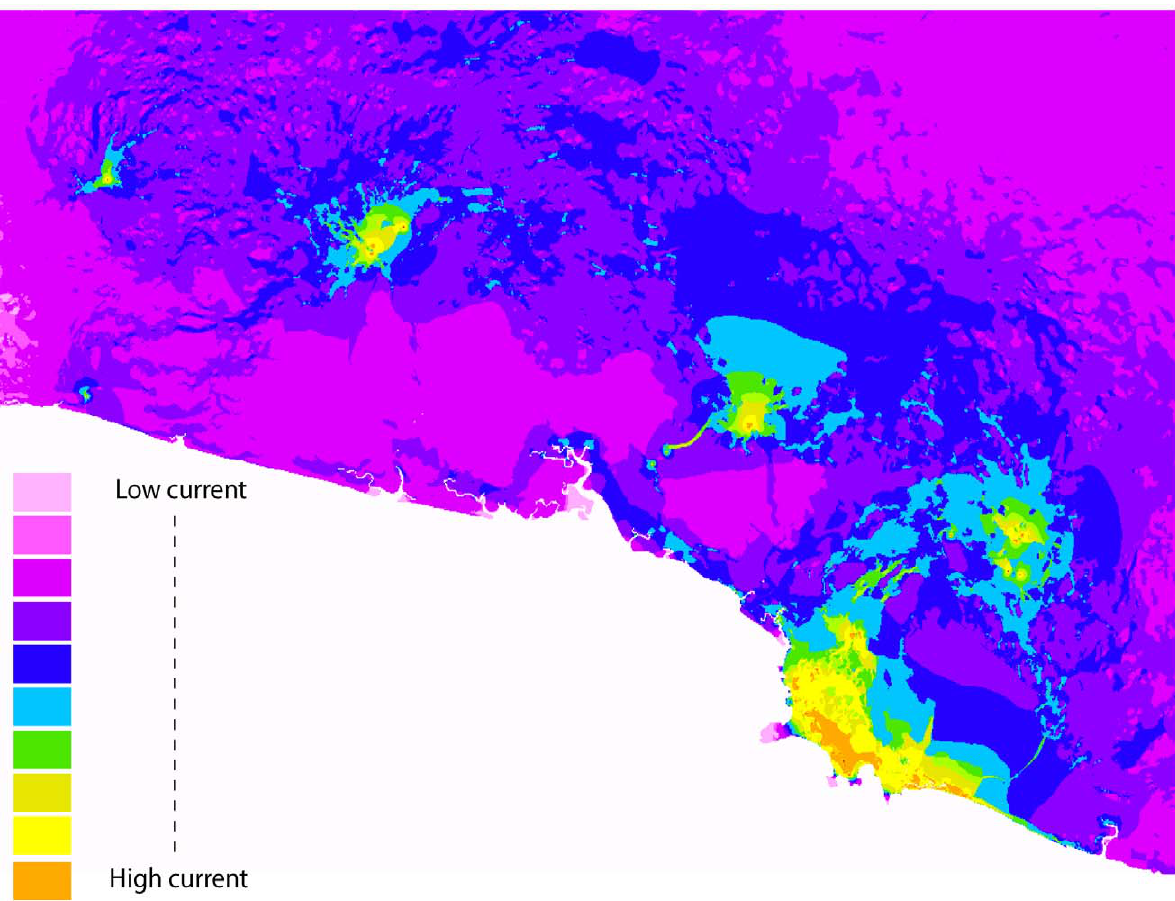
Figure 5. Cumulative resistance surface created in CIRCUITSCAPE. Cumulative resistance surface created in CIRCUITSCAPE. Forests, rivers, residential areas and cattle pastures were given very low resistance values ( , 10) and oil palm plantations were given a moderate resistance of 20.